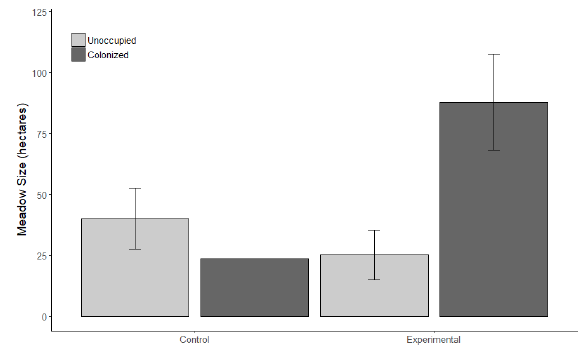
Fig. 3 . Mean size (± SE) of control and experimental meadows colonized (dark gray) and unoccupied (light gray) by Willow Flycatchers ( Empidonax traillii ) in the Sierra Nevada,